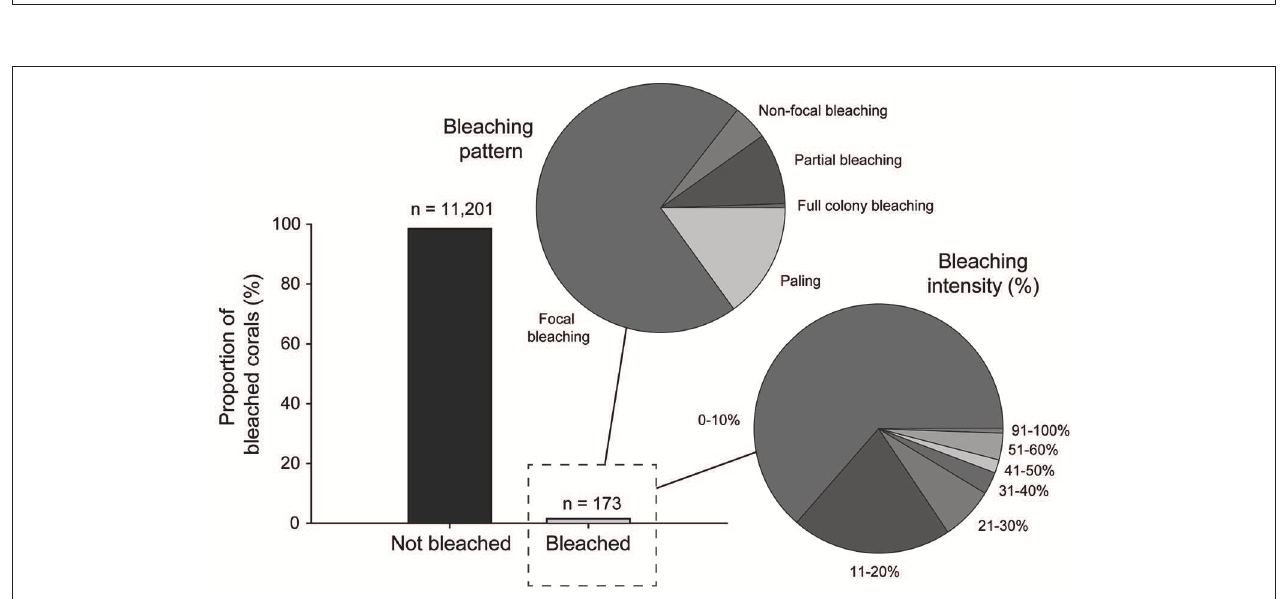
FIGURE 5 | Prevalence of non-bleached ( n = 11,201) and bleached corals ( n = 173) observed during the August 2016 surveys of the Paluma Shoals reef complex. Pie graphs illustrate the proportion of the bleached colonies that exhibit the different bleaching patterns and intensity (% of total colony surface area). Note that overall bleaching is very minor and mostly expressed as focal bleaching on < 20% of the colony surface.